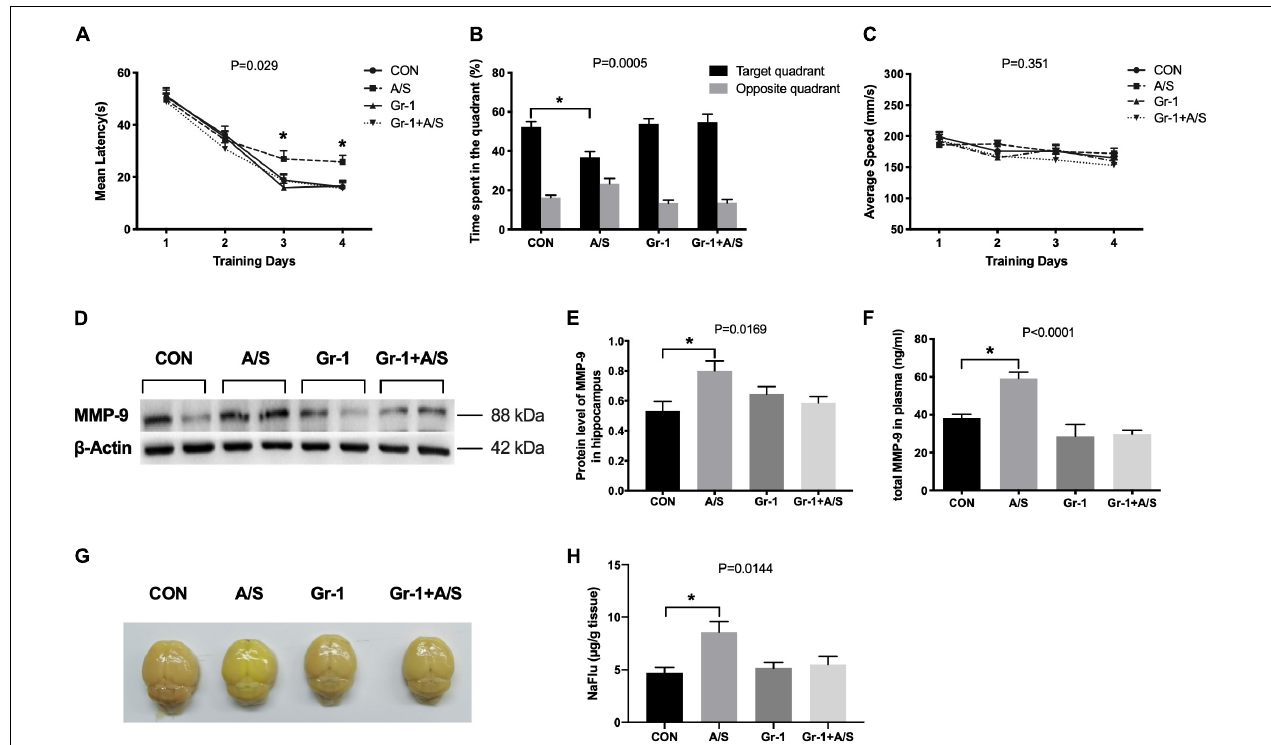
FIGURE 5 | Peripheral Gr-1 + neutrophils depletion alleviated anesthesia/surgery–induced learning and memory impairment and BBB disruption in aged mice. (A–C) In the MWM, aged mice had a profound deficit in spatial learning and memory ability after undergoing anesthesia/surgery. These mice showed an increased maze escape latency during the 4 days of repeated training trials (A) and a shorter time spent in the target quadrant in the probe test section (B) . In contrast, mice with Gr-1 + neutrophil depletion (Gr-1 + A/S) showed improvement in performance for finding the platform and stayed longer in the target area (A,B) . In addition, there was no difference in the average swimming speed among these four groups (C) , (A) , F ( 3 , 44 ) = 3.293, P = 0.029; (B) , P = 0.0005; (C) , F ( 3 , 44 ) = 1.122, P = 0.351 ( n = 12 per group). (D,E) Depletion of peripheral Gr-1 + neutrophils alleviated the elevation of MMP-9 induced by anesthesia/surgery in the hippocampus, P = 0.0169. (F) Compared with the control group, the total MMP-9 concentration in the plasma of the anesthesia/surgery group showed a remarkable increase at 24 h after anesthesia/surgery; by contrast, there was no difference after anti-Gr-1 treatment between the Gr-1 + A/S group and Gr-1 group, P < 0.0001. (G) Representative whole brains showed sodium fluorescein (NaFlu) extravasation to evaluate the BBB permeability at 24 h after anesthesia/surgery. (H) The statistical data of NaFlu in brain tissue showed the permeability of BBB increased after anesthesia/surgery but there was no significant difference between Gr-1 and Gr-1 + A/S group, P = 0.0144. Data are expressed as means ± SE ( n = 4–6 per group). * P < 0.05 compared with that of the control